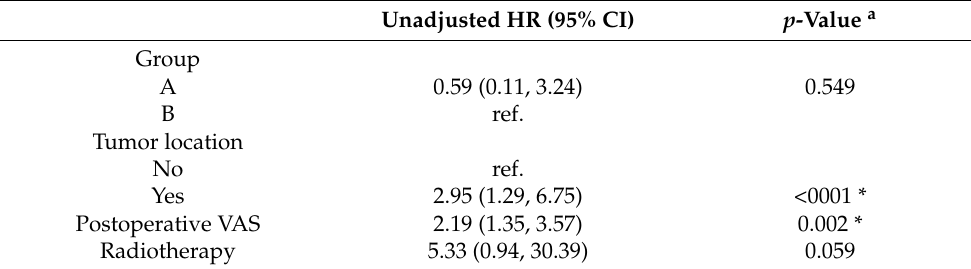
Figure 4. An implant failure case in group B: ( a ) original postoperative X-ray image, ( b ) first implant failure, and ( c ) postoperative plain radiograph after revision surgery with modified SHS. Table 3. Factors associated with implant failure and revision surgery.